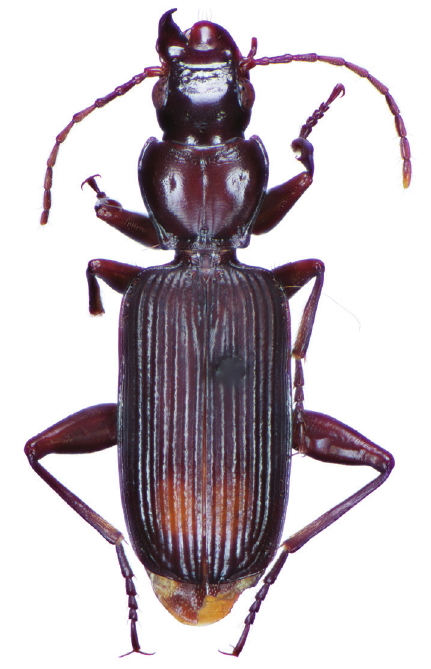
Figure 90. Dorsal habitus and color pattern of Miscelus javanus Klug. (OBL 10.18